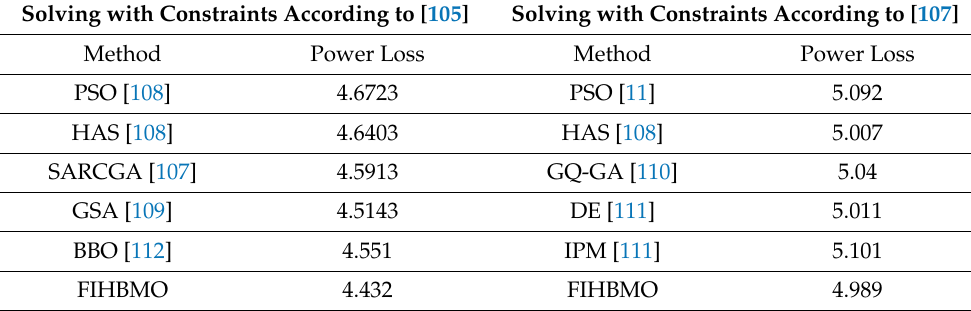
Table 4. Comparison of the proposed method with the literature results. Reproduced from [106], Elsevier: 2009 and from [107] Elsevier: 2011.